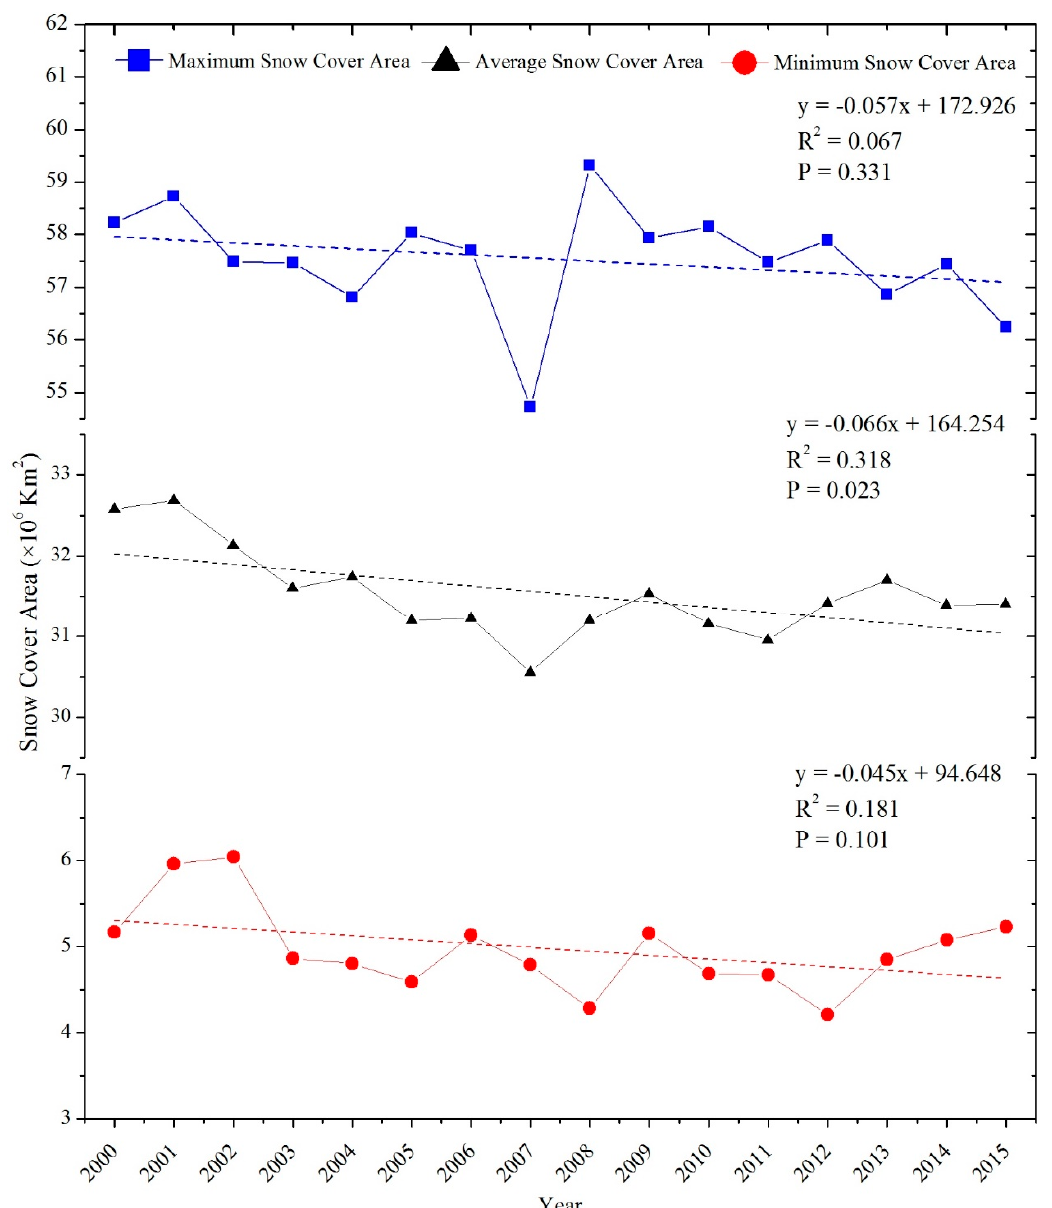
Figure 4. Annual maximum, average and minimum snow-covered area in the Northern Hemisphere from 2000 to 2015.